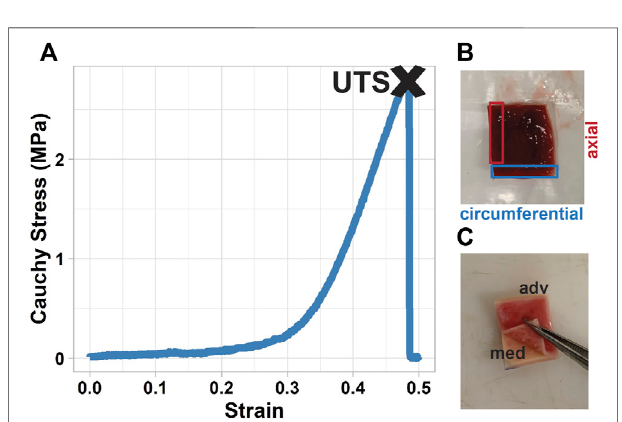
FIGURE 2 | Uniaxial analysis and layer-separation of tissue. (A) stress- strain curve of a uniaxial test, with ultimate tensile strength (UTS) found as the stress of the tissue at failure; (B) uniaxial specimens were directly adjacent to thebiaxialspecimen,cutfromthetissue inboththecircumferential(blue) and axial (red) directions; (C) manual layer-separation of the tissue was done after biaxial testing, before the tissue was analyzed for collagen content.